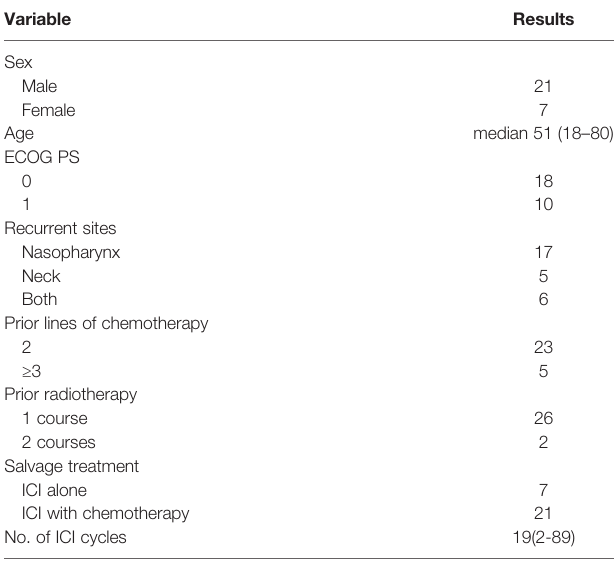
TABLE 2 | Clinical characteristics of the 28